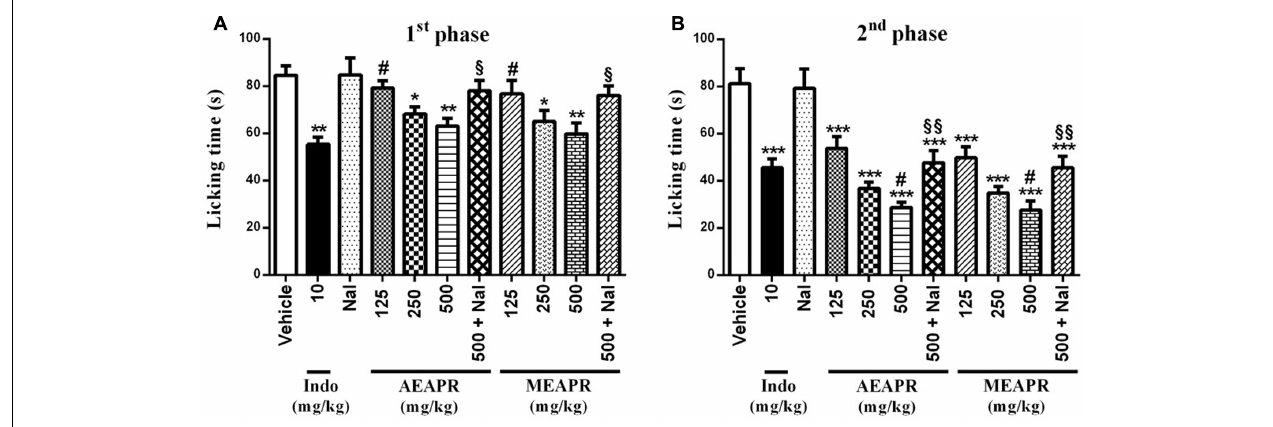
FIGURE 7 | Effect of MEAPR and AEAPR on the paw licking response induced by formalin in mice. Animals were treated orally with vehicle (distilled water), indomethacin (Indo), MEAPR or AEAPR (125, 250, 500 mg/kg or 500 mg/kg + naloxone, prior to intraplantar injection of formalin (20 µ l). Naloxone was administered alone or 30 min before administration of AEAPR and MEAPR. The total time spent licking the hind paw was measured (A) in the first phase (0–5 min) and (B) in the second phase (15–30 min) after intraplantar injection of formalin. Vertical bars represent mean ± SEM of licking time for six mice in each group. The symbols denote the significance levels (one-way ANOVA followed by Newman–Keuls test): ∗ p < 0.05, ∗∗ p < 0.01, and ∗∗∗ p < 0.001 compared with the vehicle-treated group; # p < 0.05 compared with the indomethacin-treated group. AEAPR, aqueous extract of Anacyclus pyrethrum root; MEAPR, methanol extract of Anacyclus